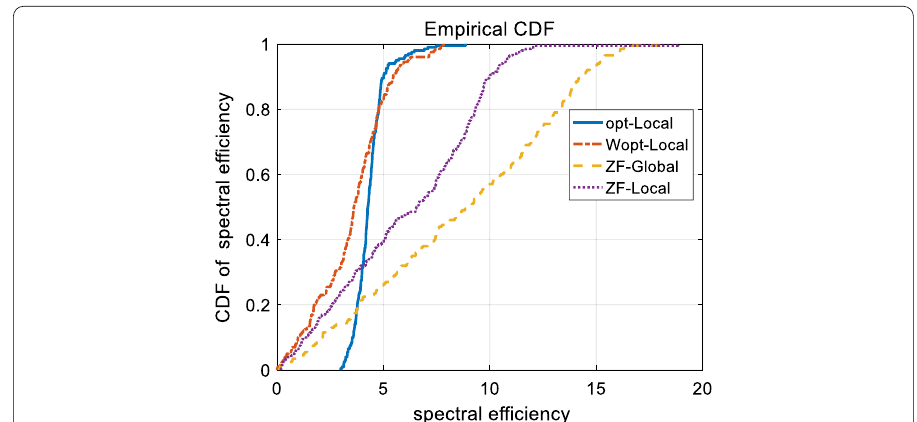
Fig. 9 Comparison of spectral efficiency of using MRC (optimized and not optimized) and ZF (local processing [43] and global processing), α 2 =